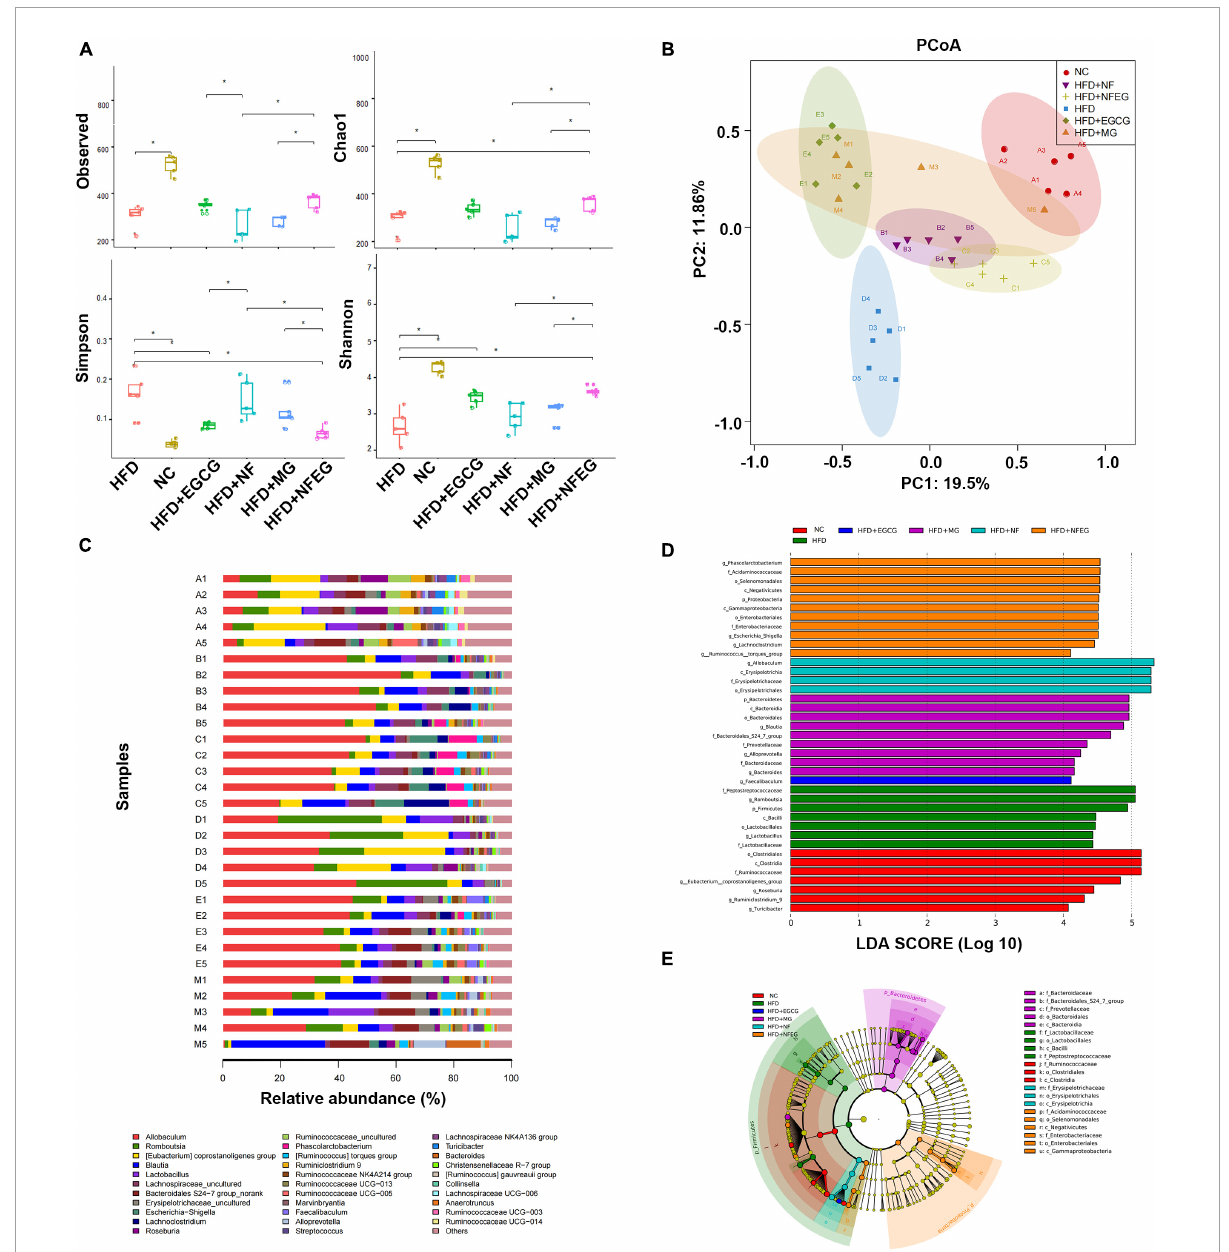
FIGURE6 NFEG-microgel changed the diversity and composition of gut microbiota in HFD-fed rats. (A) α -diversity index (observed, Chao1, Shannon, and Simpson index). (B) Bray–Curtis PCoA plot based on the OTU abundance of each rat. (C) Heat map of bacterial taxonomic profiling at the genus level of intestinal bacteria based on each rat from different groups: NC group (A1–A5), HFD + NF group (B1–B5), HFD + NFEG group (C1–C5), HFD group (D1–D5), HFD + EGCG group (E1–E5), and HFD + MG group (M1–M5). Linear discriminant analysis (LDA) scores (D) and cladogram (E) generated from linear discriminate analysis effect size (LEfSe) analysis, showing the biomarker taxa (LDA score of > 4 and a significance of P < 0.05 determined by the Wilcoxon signed-rank test). Significant difference was indicated with the sign ∗ P < 0.05 and ∗∗ P <